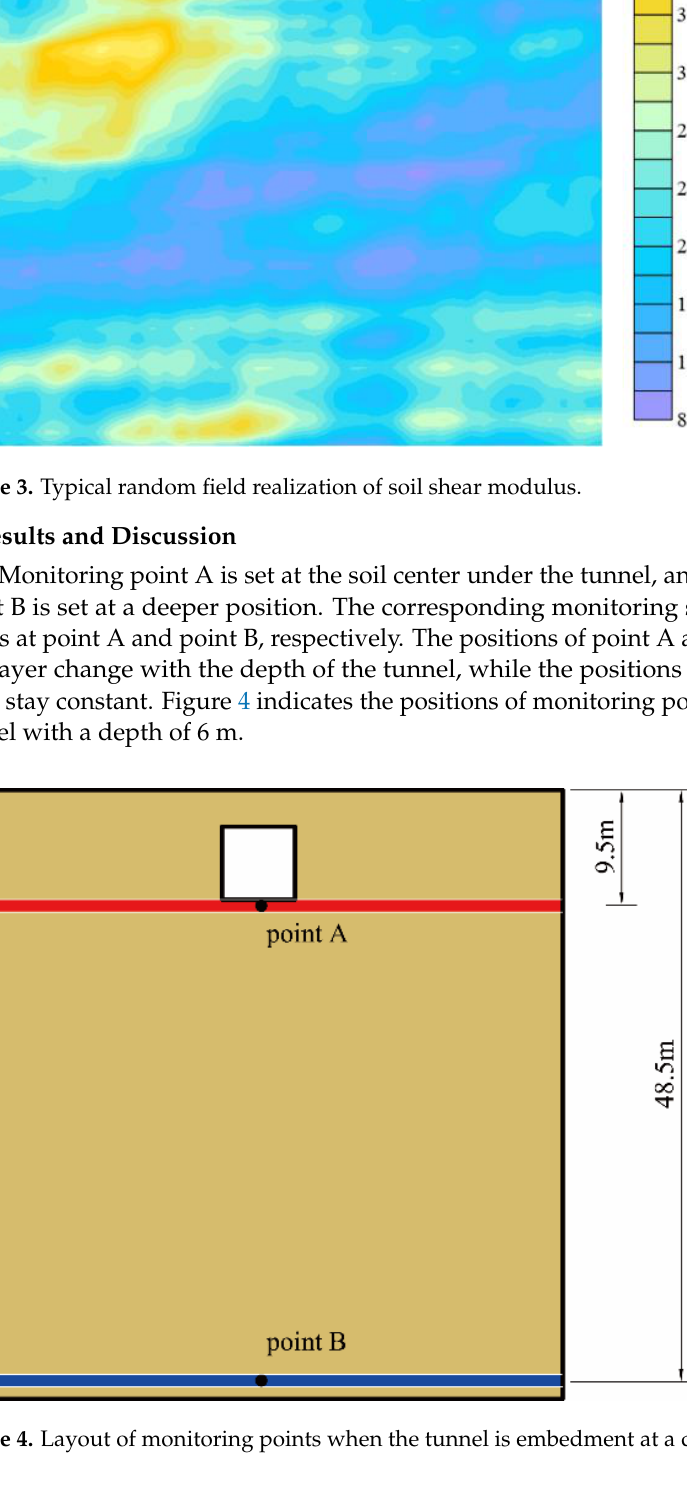
Figure 4. Layout of monitoring points when the tunnel is embedment at a depth of 6 m.